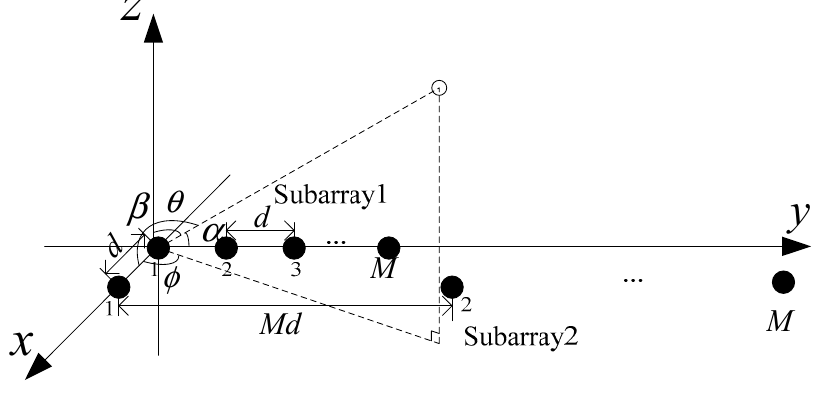
Figure 1. Two-parallel nested array structure.